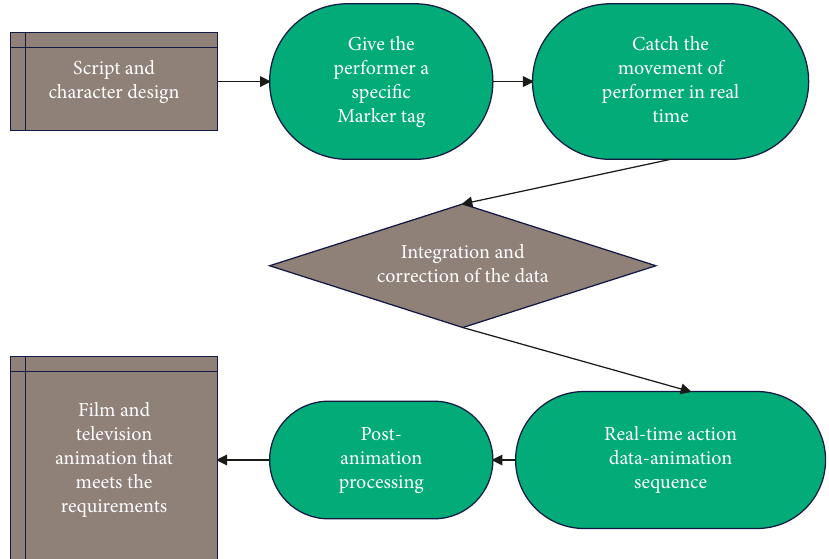
Figure 5: The production process of film and television animation in the motion capture system.